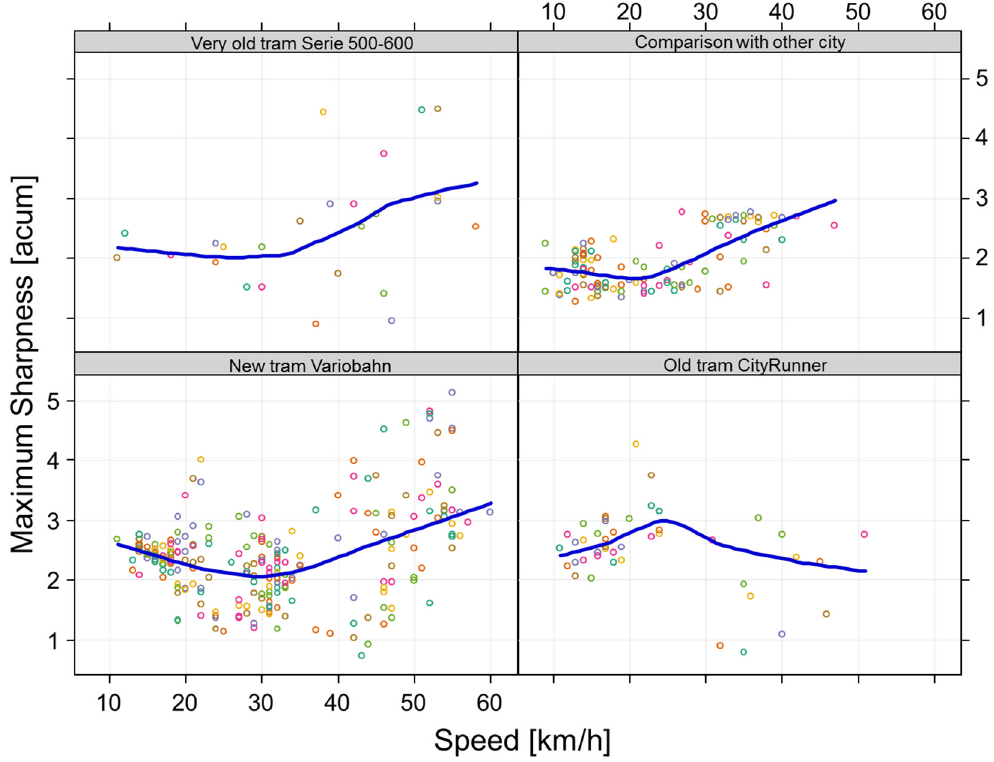
Figure 14. Maximum of Sharpness in (acum) by speed over all measuring points subdivided by tram type with a comparison of trams in a different city (upper right